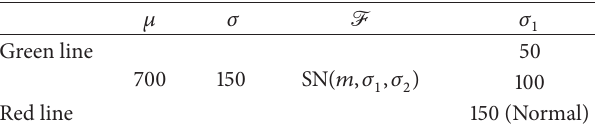
Table 5: The parameters 𝑚 and 𝜎 2 below are adjusted as 𝜎 1 changes so as to keep 𝜇 and 𝜎 constant.